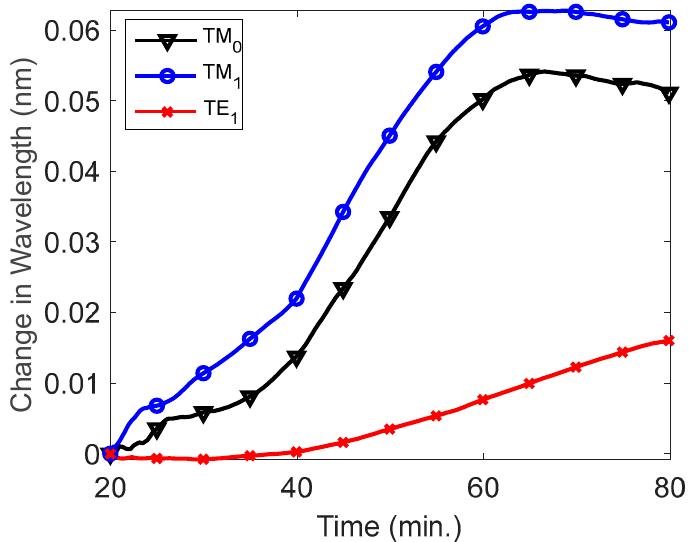
Figure 12. Resonance wavelength shifts while the sensor is incubated in a yeast and PBS solution (8.25 × 10 5 cells/mL). The TM 0 , TM 1 , and TE 1 modes are labeled in the legend as black, blue, and red, respectively.